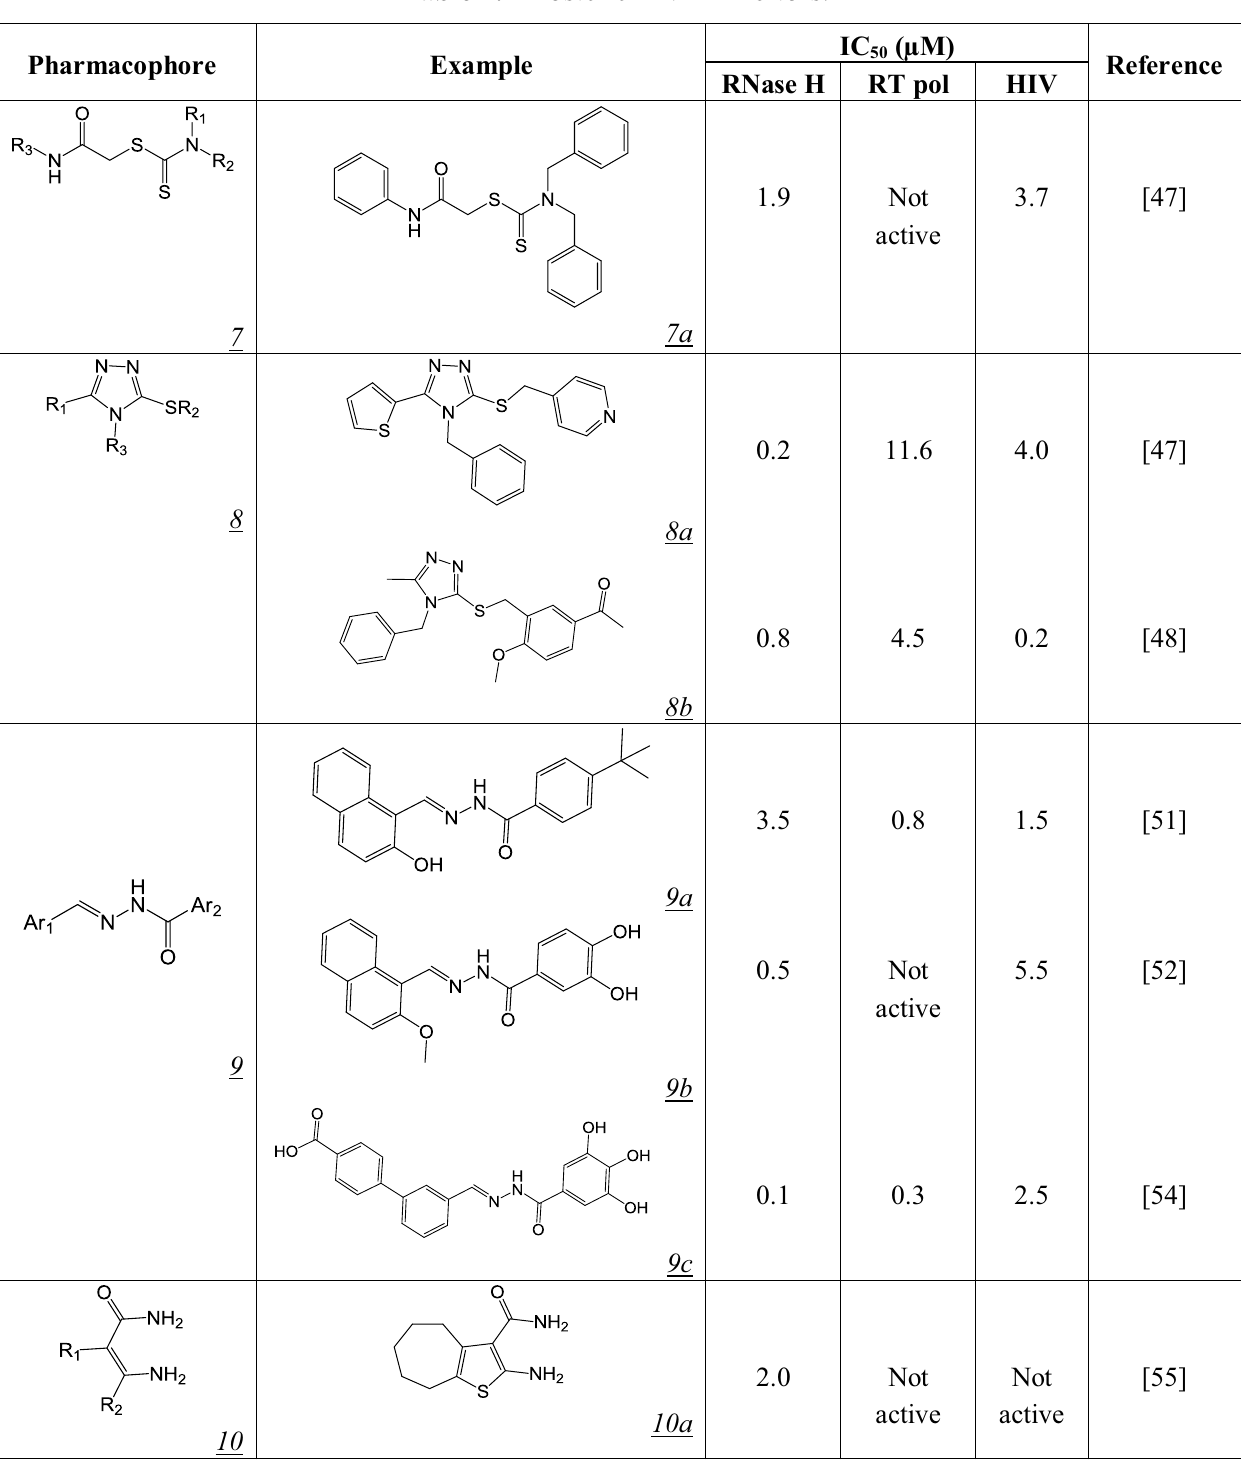
Table 2. Allosteric RNH